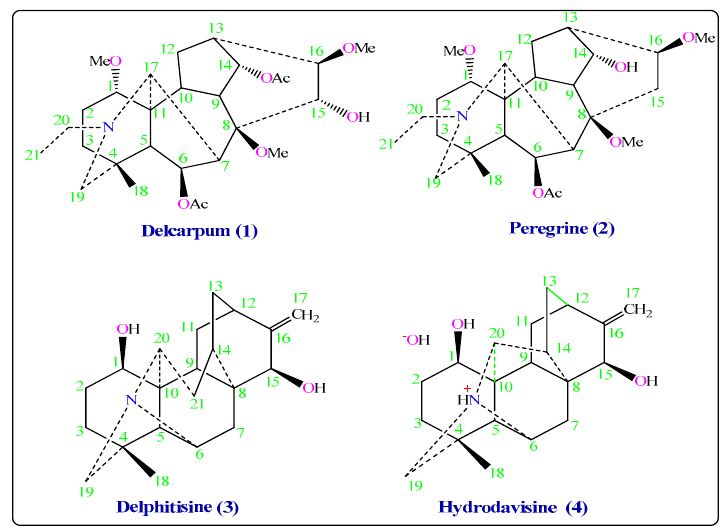
Figure 1. Chemical structures of the isolated compounds ( 1 – 4 ).